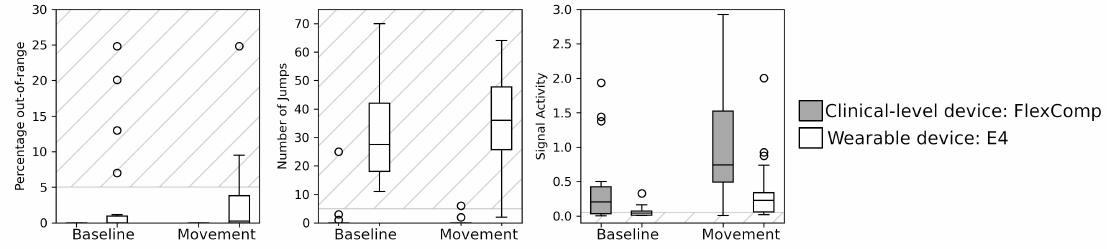
Figure 7. SQIs of the EDA signals collected from the FlexComp (gray) and E4 (white). Striped areas indicate the ranges of SQI values associated with low signal